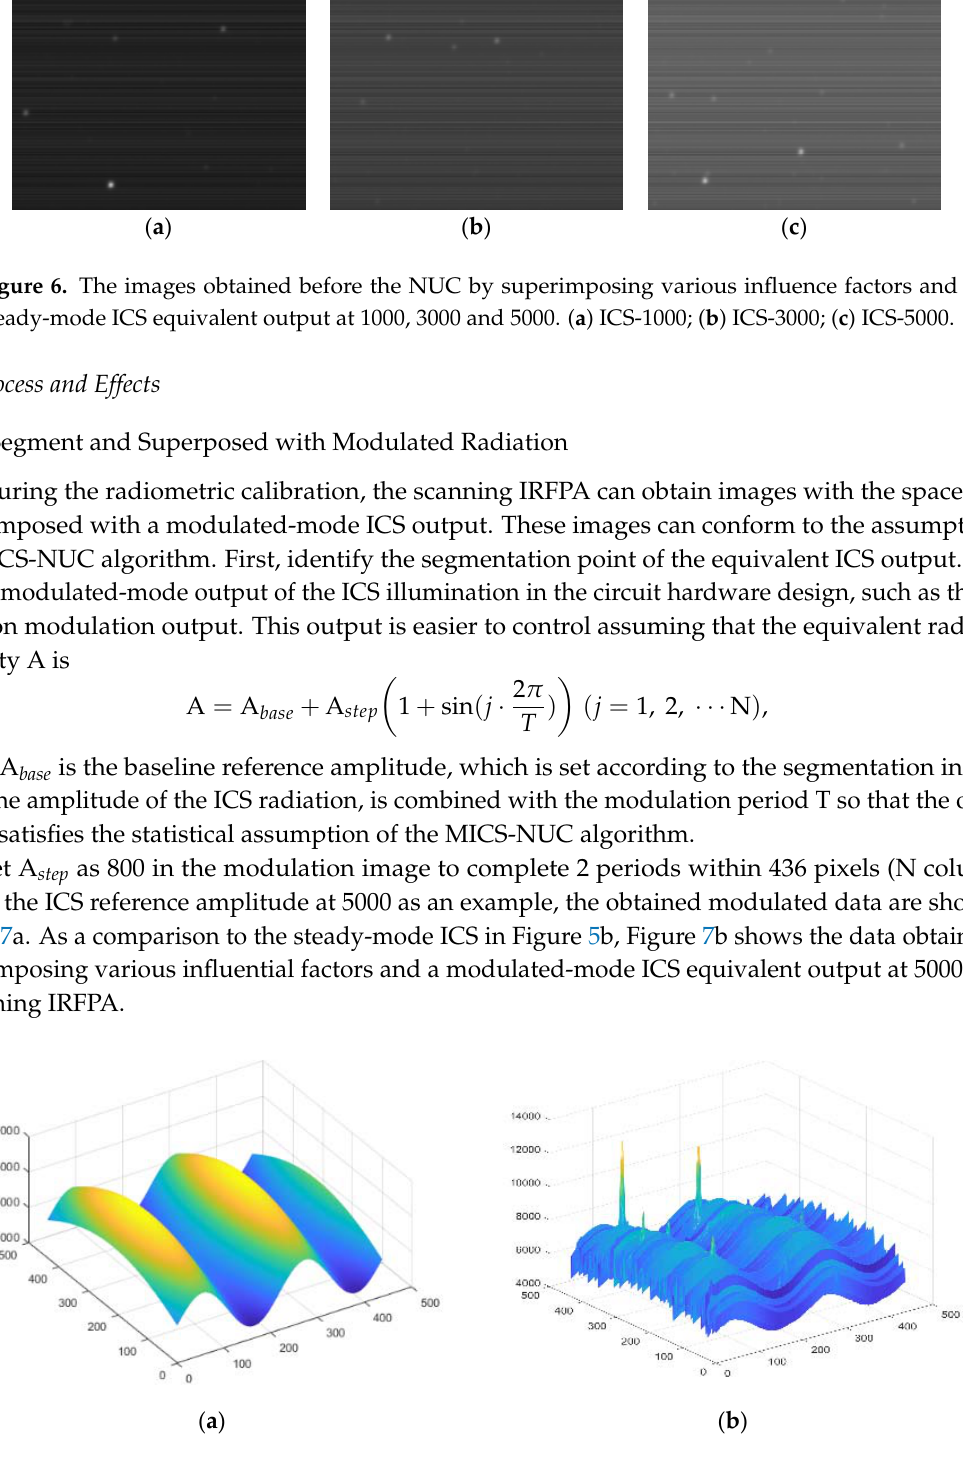
Figure 7. Data obtained by a scanning IRFPA with a modulated ‐ mode ICS output (ICS equivalent output: 5000): ( a ) modulated ‐ mode ICS radiance distribution when the ICS equivalent radiance output is 5000; ( b ) actual space scene data superposed with a modulated ‐ mode ICS output and various influential factors.